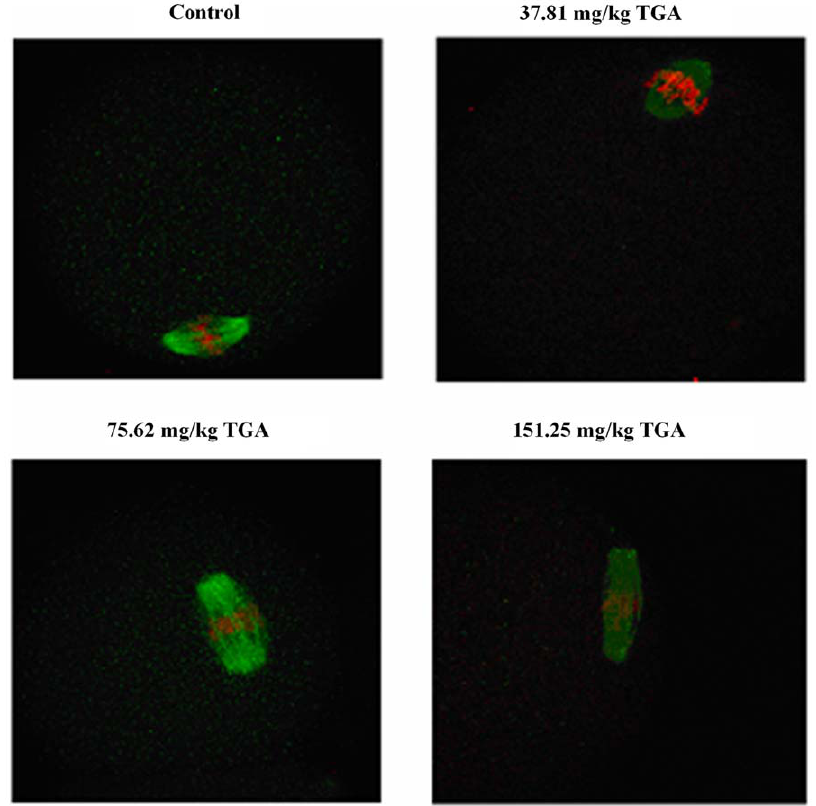
Figure 2. Effect of TGA on the spindle morphology of invivo matured oocytes ( 6 600). The oocytes were stained immunocytochemically with anti- a -tubulin monoclonal antibody and fluoroscein isothiocyanate to observe the spindle (green). Counterstaining with PI was also performed to detect the chromosomes (red). doi:10.1371/journal.pone.0023996.g002 Spindle formation and CG distribution are both indicators of oocyte maturation. A meiotic spindle is composed of microtubules and appears from the late G2 phase to the end of the M phase. Meiotic spindles are crucial for normal chromosome alignment as